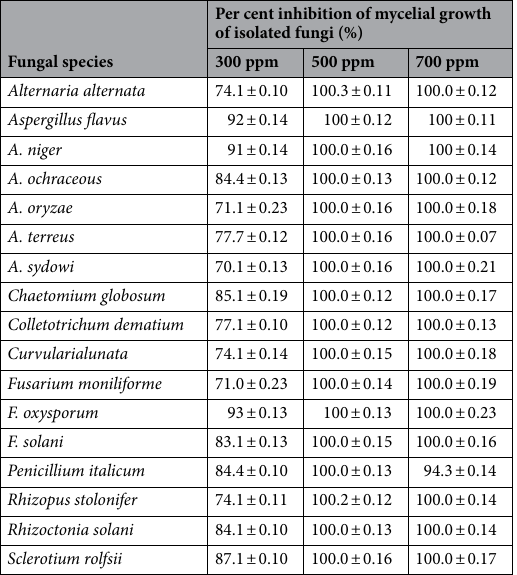
Table 4. Fungitoxic spectrum of mixture oil (Lavang and sowa leaf oil in 1:1 ratio) at different concentrations against fungi isolated from stored chickpea food seeds. SD standard deviation. *Values given are mean of three replicates.